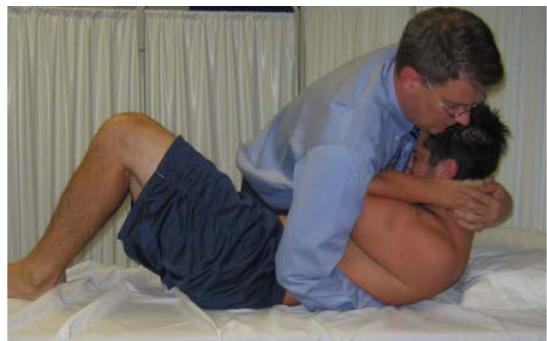
FIGURE 5. Manipulation to the mid-thoracic spine.